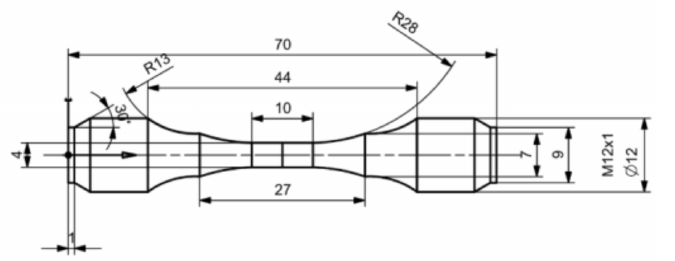
Figure 2. Manufactured and tested fatigue specimen used in this study. The testing area was applied with the different